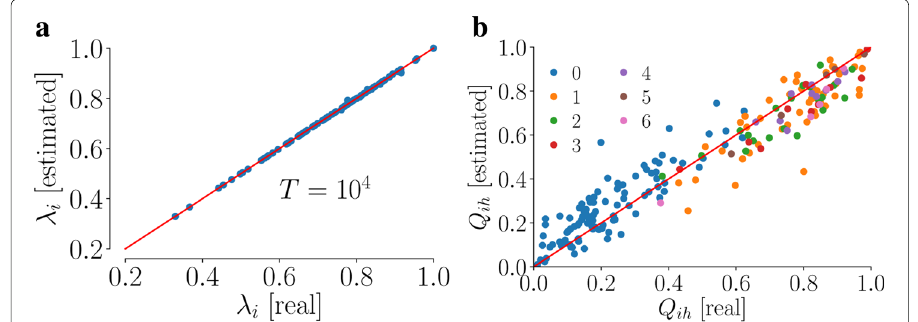
Fig. 8 Identification performance for T small, reducing γ i . Estimation of ( a ) the vector λ and ( b ) the matrix Q for T = 10 4 , using the optimal value of γ i ∈ [0, ¯ γ i ], i ∈ V , selected using a bisection method. The optimal value of γ i is in average 18% of the extreme value ¯ γ